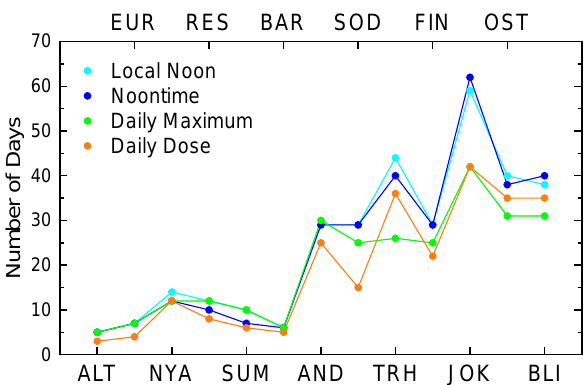
Fig. 5. Number of days between the day when the maximum relative UV increase occurred in 2011 and the day when the same UV level is typically observed. The color coding is the same as in Fig.